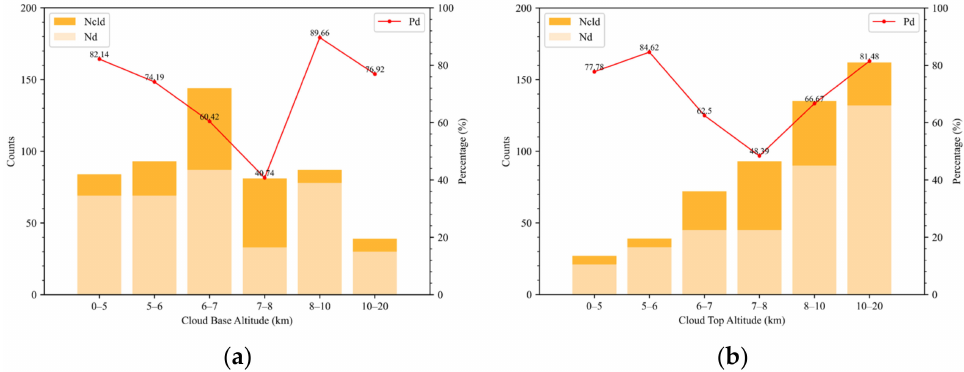
Figure 8. The data count of cloudy data in the CALIPSO product (orange bar), and that detected by the cloud index (bisque bar), red curves are for the detection rate of cloudy data varying with ( a ) cloud base altitudes and ( b ) cloud top altitudes in August